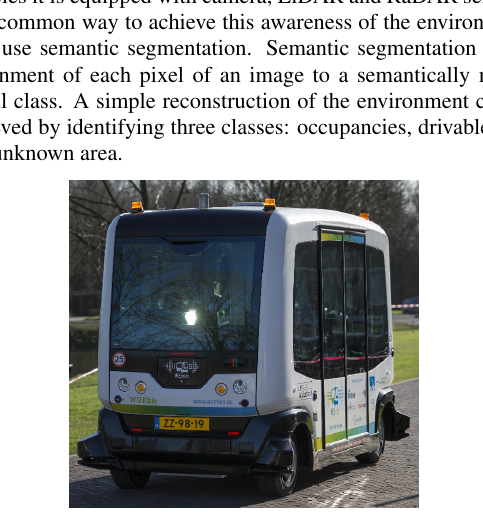
Figure 1: WUrbie: one of the two WEpods in the